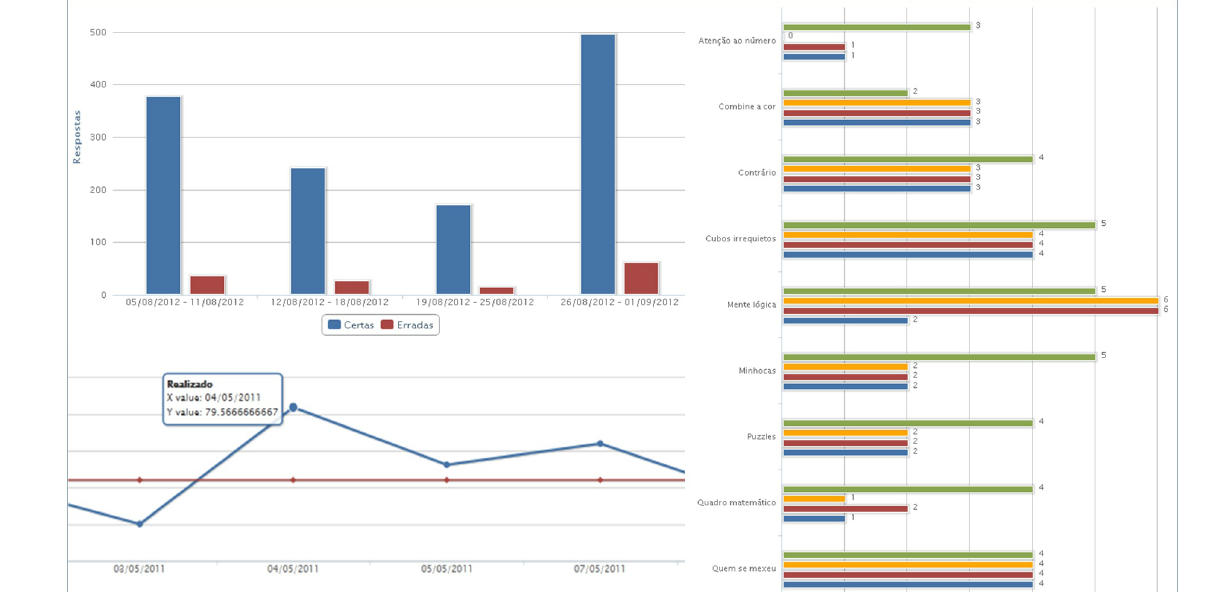
Figure 4. Examples of progress